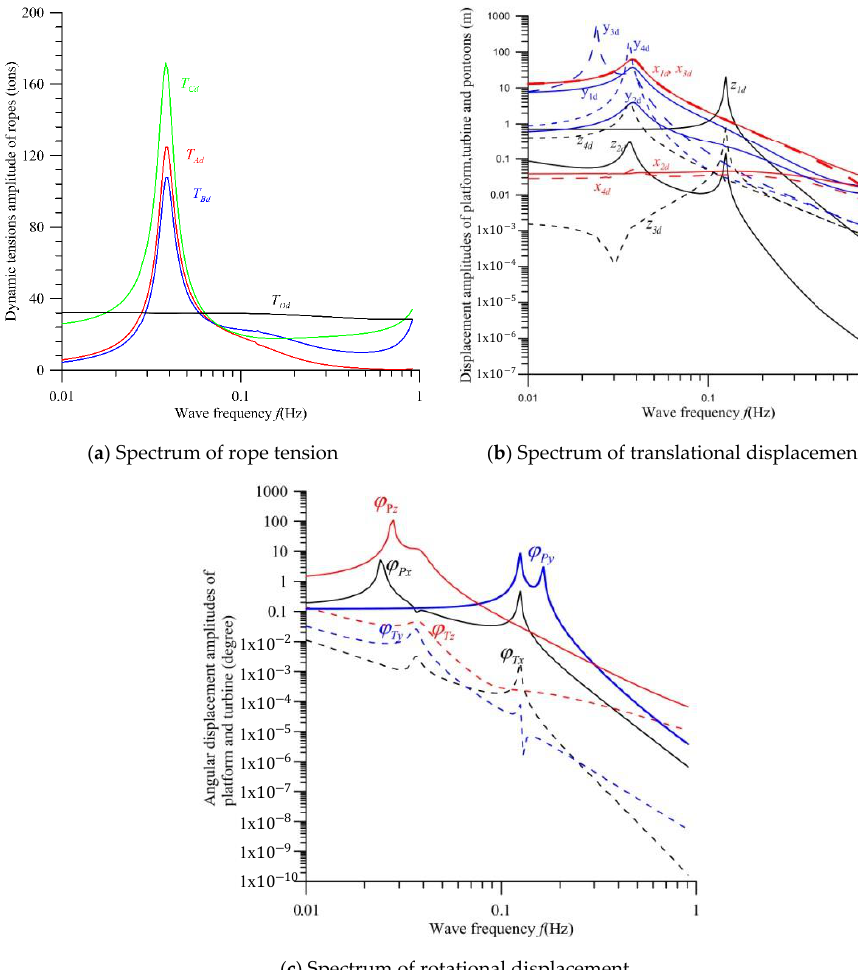
C = 140 m, L D = 60 m β P